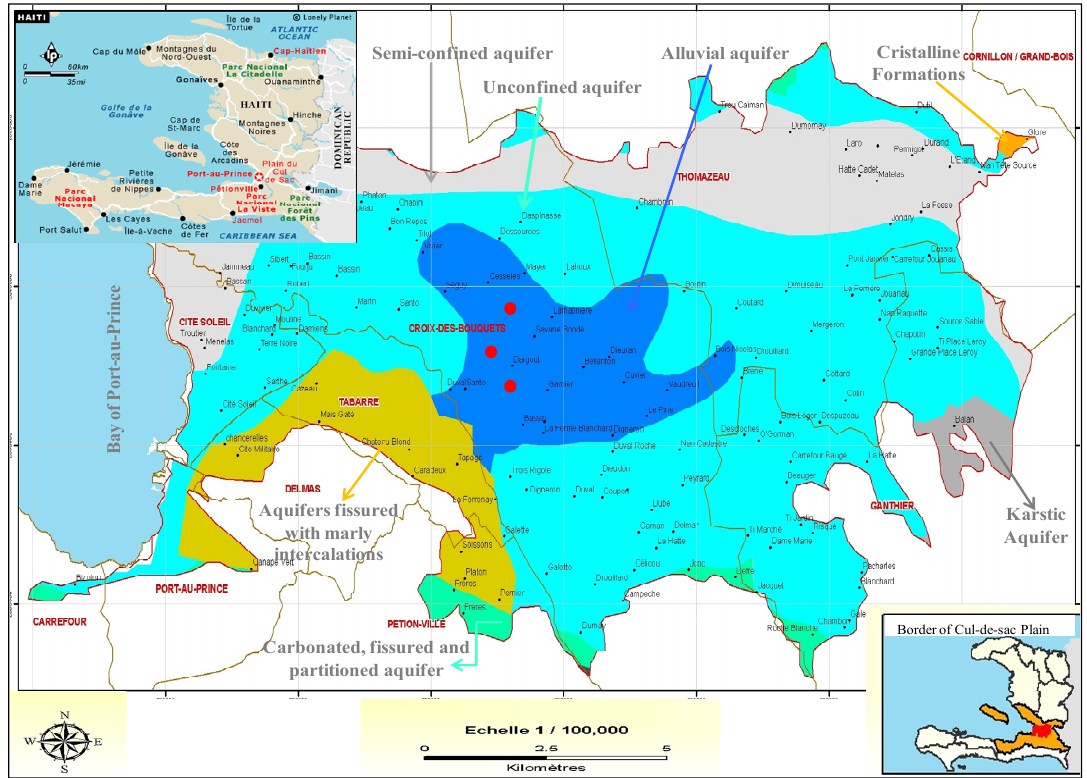
Figure 1. Aquifer systems of Cul-de-sac Plain, Haiti (sampling points